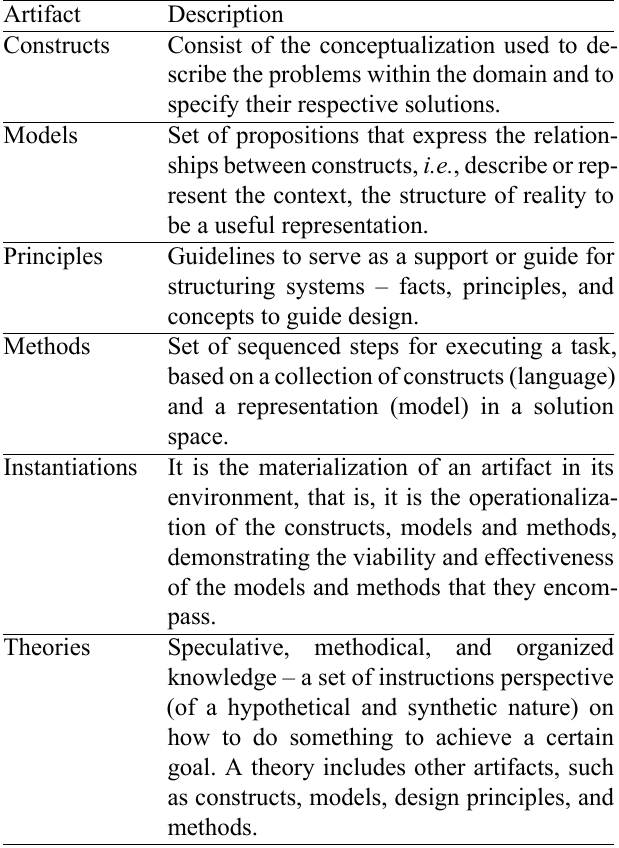
Table 1. Types of artifacts. Source: Reis